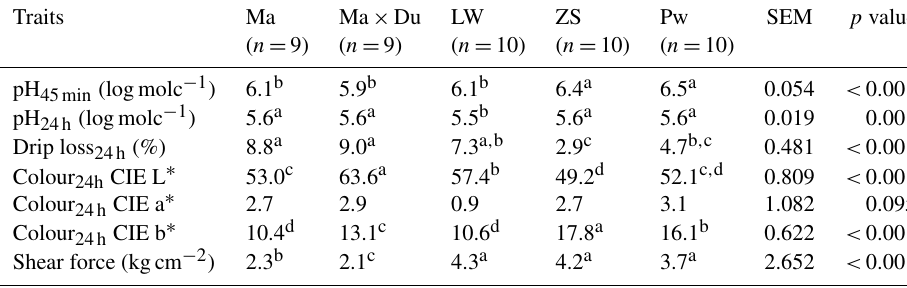
of CIE b ∗ was the highest in MLD of Zlotnicka spotted, which is probably due to the higher share of intramuscu- lar fat in MLD from Zlotnicka spotted. The lowest values of CIE b ∗ were found in MLD from Mangalitsa and Large White compared to the MLD of other genotypes in the is- sue ( P < 0.001). Similarly, Sirtori et al. (2011) indicated that crossbreeds of Nero Siciliano exhibited darker, redder meat with higher values of yellowness than meat from indigenous breed Nero Siciliano. Several lines of Iberian pigs and Chato Murciano exhibited lower values of lightness in meat but higher values of yellowness than our study. Values of red- ness are in accordance with results reported by several au- thors (Estévez et al., 2003; Juárez et al., 2009; Peinado et al., 2004). On the other hand, Poto et al. (2007) noted that indige- nous breed Chato Murciano had higher values of colour pa- rameters in meat than their crossbreeds. The results showed that Polish indigenous breed had lower values of drip loss in meat, darker and more yellow meat than genotypes from Slo- vakia. It can be concluded that the crossbreed Ma × Du had PSE meat due to low values of pH45 min, higher content of drip loss as well as higher content of colour value L ∗ than other genotypes in this